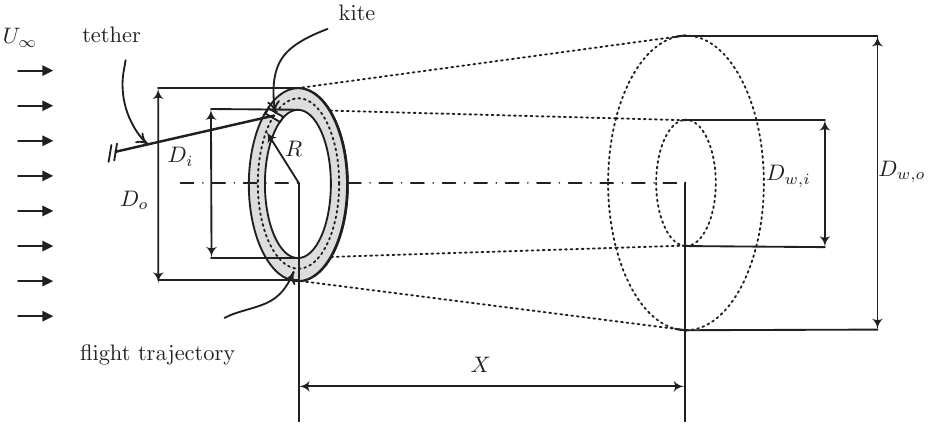
Figure 9. A schematic drawing showing axisymmetric wake flow (dotted line) developed downstream of a crosswind kite in the straight downwind configuration. The incoming wind speed is represented by U ∞ , and it is considered to be steady and uniformly distributed. The kite sweeps an annulus with D i and D o representing the inner and outer diameters, respectively, and R = ( D i + D o ) /4 denoting the gyration radius; also, the inner and outer diameters of the wake are represented by D w , i and D w , o , respectively. See Figure 10 which shows a section of the wake flow (dotted line) downstream of a crosswind kite and that of the control volume CV1 (hatch pattern) enclosing a flow region downstream the rotation plane. The boundaries of CV1 are specified by ABCDA